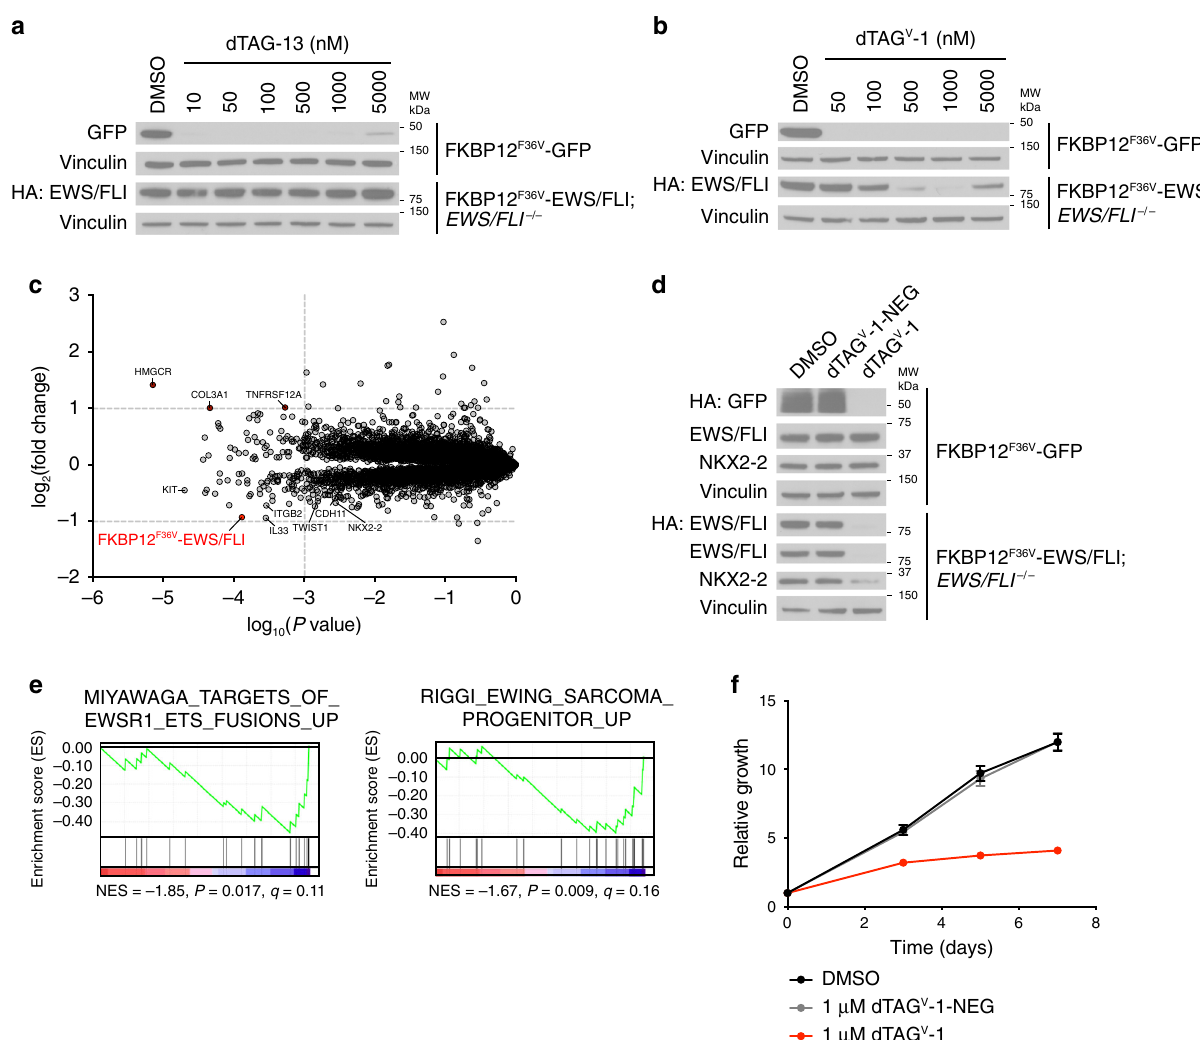
Fig. 3 EWS/FLI degradation reverses abnormal proteomic signaling and proliferation. a , b Immunoblot analysis of EWS502 FKBP12 F36V -GFP or FKBP12 F36V -EWS/FLI; EWS/FLI − / − cells treated with DMSO ( a , b ), dTAG-13 ( a ), or dTAG V -1 ( b ) for 24 h. Data in a , b are representative of n = 3 independent experiments. c Protein abundance after treatment of EWS502 FKBP12 F36V -EWS/FLI; EWS/FLI − / − cells with 1 μ M dTAG V -1 for 6 h compared to DMSO treatment. Volcano plots depict fold change abundance relative to DMSO versus P value derived from a two-tailed Student ’ s t -test. Fold change values and signi fi cance designations derived from a two-tailed Student ’ s t -test and a permutation-based FDR estimation are provided in Supplementary Data 2. Data are from n = 2 for DMSO and n = 3 for dTAG V -1 biologically independent samples. d Immunoblot analysis of EWS502 FKBP12 F36V -GFP or FKBP12 F36V -EWS/FLI; EWS/FLI − / − cells treated with DMSO, 1 μ M dTAG V -1 or 1 μ M dTAG V -1-NEG for 24 h. Data are representative of n = 3 independent experiments. e GSEA signatures upon assessment of signi fi cantly differentially expressed target proteins (FDR < 0.05) after treatment of EWS502 FKBP12 F36V -EWS/FLI; EWS/FLI − / − cells as described in c . Data are from n = 2 for DMSO and n = 3 for dTAG V -1 biologically independent samples. f Relative growth of EWS502 FKBP12 F36V -EWS/FLI; EWS/FLI − / − cells treated with DMSO, dTAG V -1, or dTAG V -1-NEG. Y -axis represent luminescence values relative to day 0. Data are presented as mean ± s.d. of n = 8 technical replicates and are representative of n = 3 independent experiments. Source data for a , b , d , and f are provided as a Source Data fi